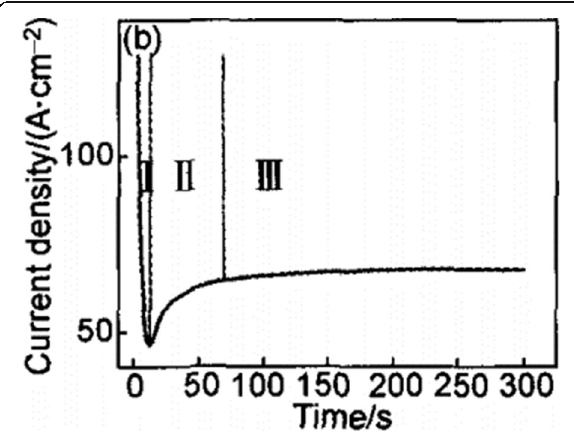
Fig. 6 Typical current time curve under a constant voltage in electrolytes containing fluoride. The transient can be divided into three distinct regions ( I – III ). ( I ) In the first part, there is a sharp current decay. ( II ) In the second part, the current begins to rise again with a time lag. ( III ) In the third part, the current reaches a steady state reproduced from ref.